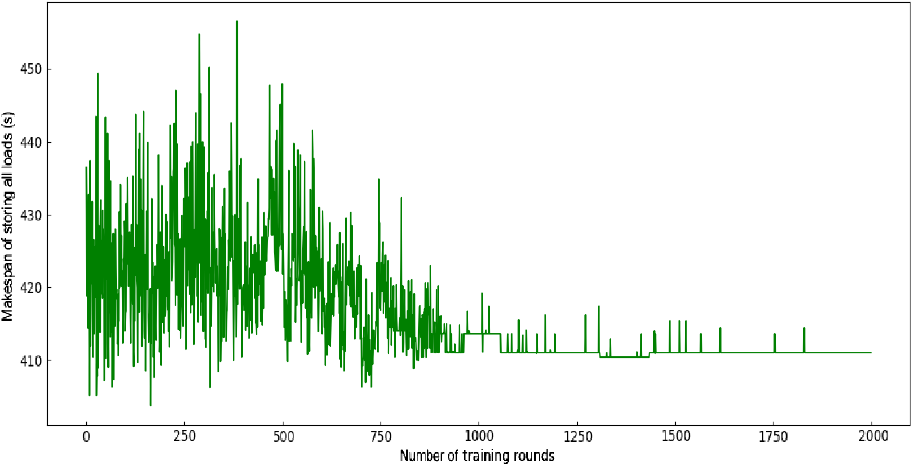
Fig. 9 Training process of AC algorithm on